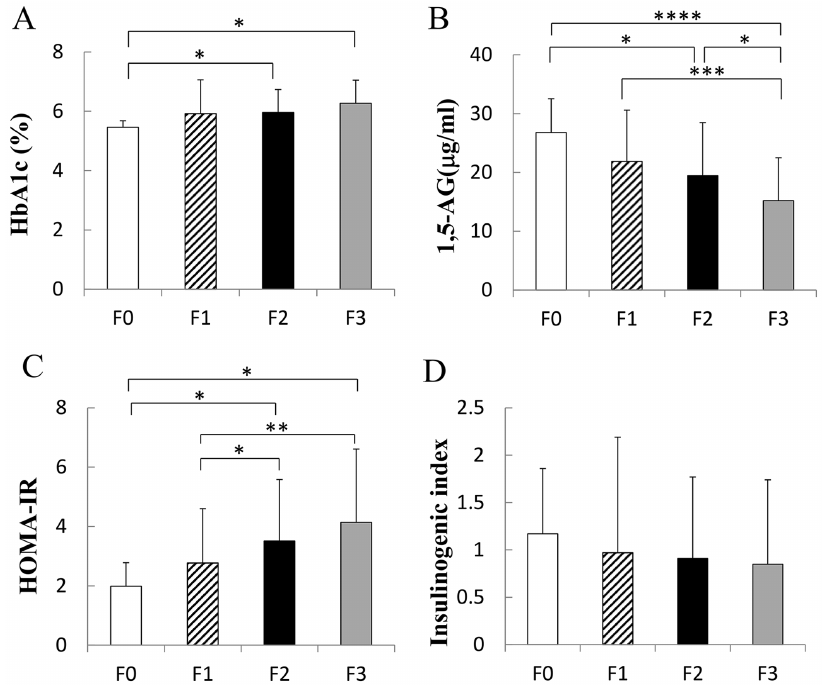
Figure 2. Relationship between hepatic fibrosis and various parameters of glucose metabolism. A) HbA1c was significantly elevated in accordance with the progression of hepatic fibrosis (F0 versus F2, * P , 0.05; F0 versus F3, ** P , 0.05; N=169). B) 1,5-Anhydroglucitol (1,5-AG) levels were remarkably decreased with the progression of hepatic fibrosis (F0 versus F2, * P , 0.05; F0 versus F3, **** P , 0.0001; F1 versus F3, *** P , 0.001; F2 versus F3, * P , 0.05; N=169). C) HOMA-IR was significantly elevated in the patients with advanced hepatic fibrosis (F0 versus F2, * P , 0.05; F0 versus